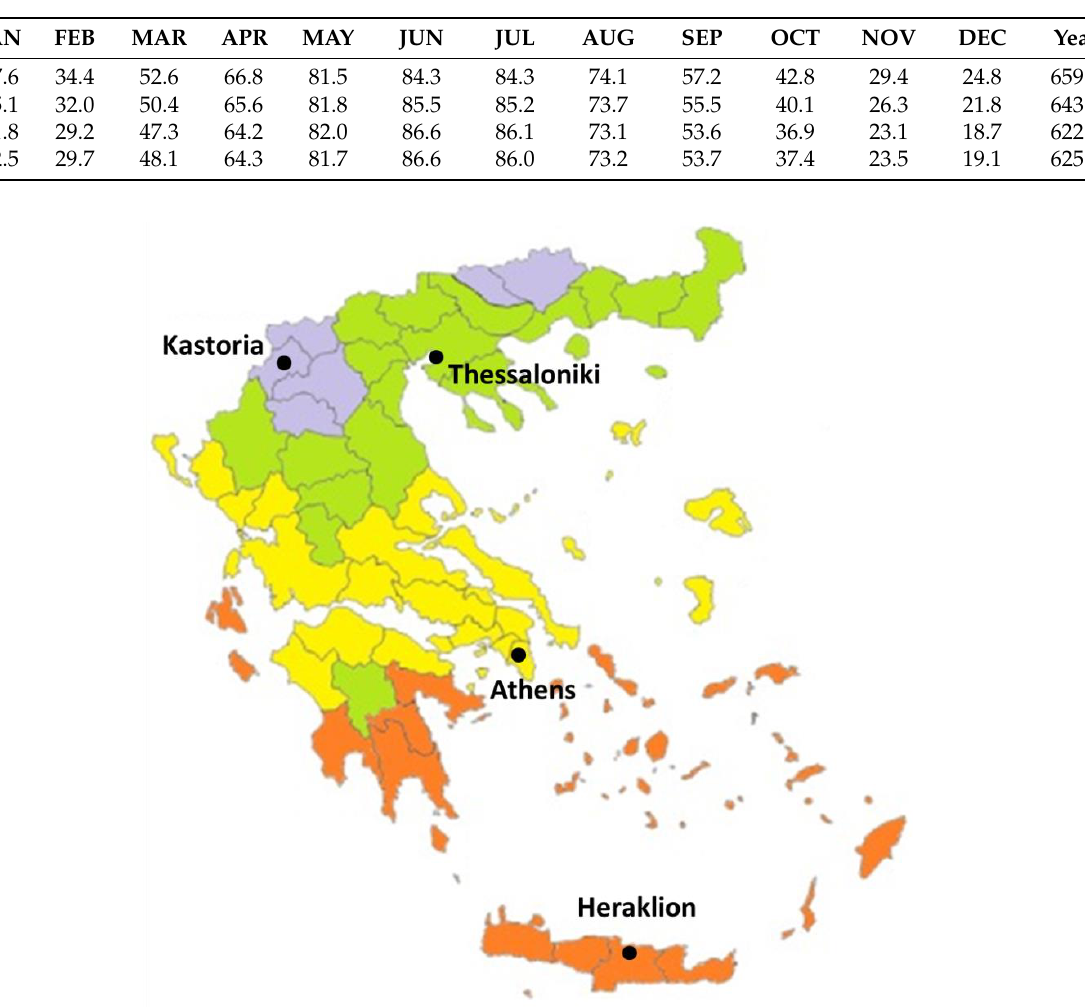
Table 4. Data for the daily diffuse solar irradiation on the horizontal surface (H d ) in [kWh/m 2 ].